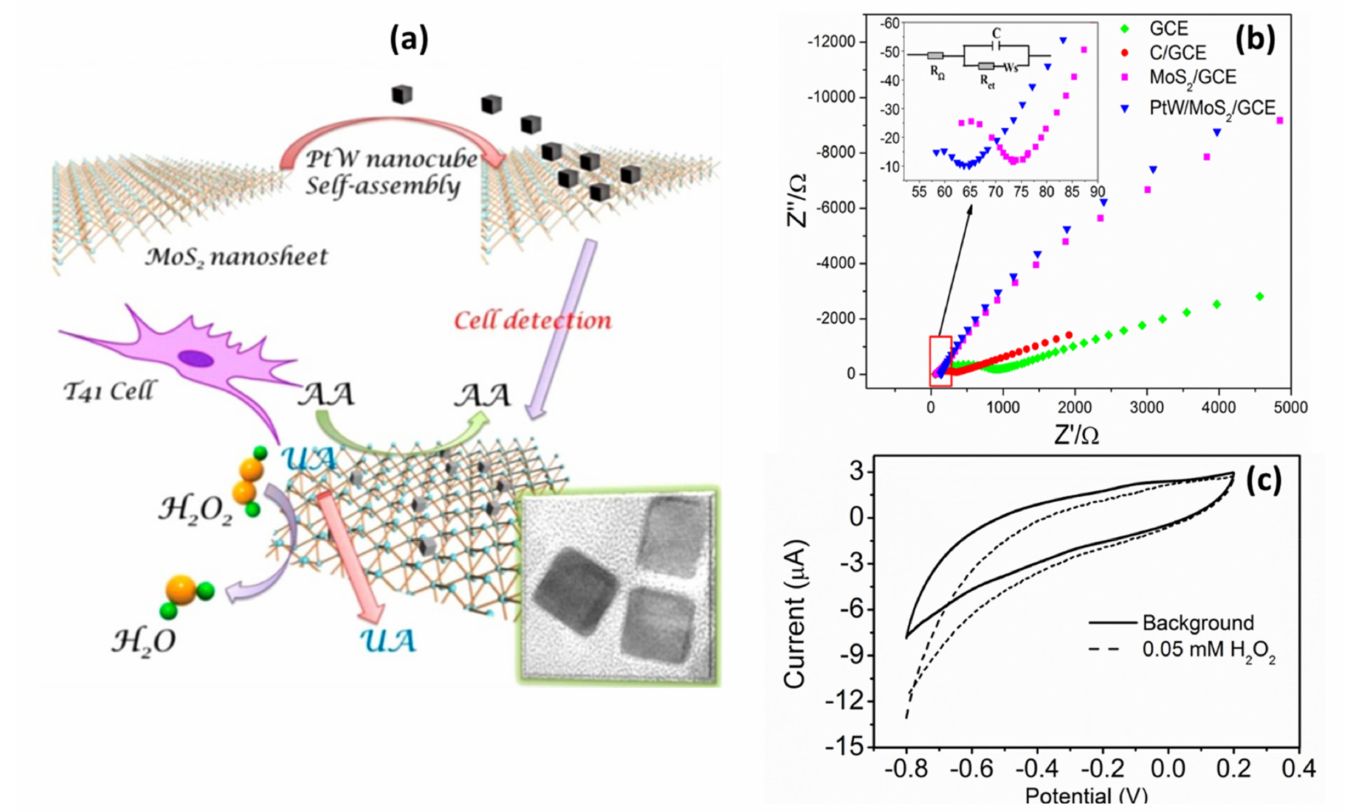
Figure 9. ( a ) Schematic representation of the PtW-MoS 2 nanocomposite sensor for the detection of H 2 O 2 released from living cells (AA: ascorbic acid, UA: uric acid). ( b ) EIS response of bare and modified electrodes in a solution containing 0.1 M KCl and 2 mM Fe(CN) 63 − -Fe(CN) 64 − . The equivalent circuit used to fit the Nyquist plots obtained from modified electrodes is shown in